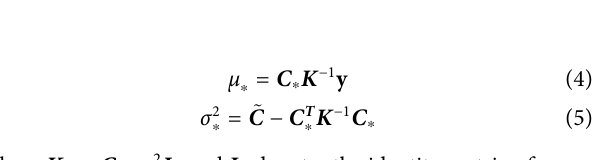
FIGURE 1 | Cracks measured by the GPS points on the front part of the